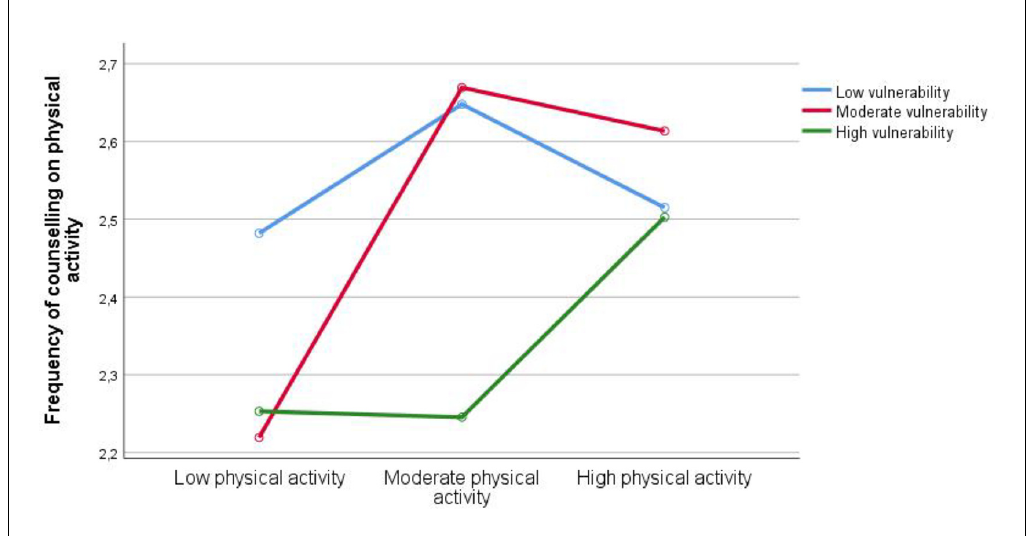
Figure 3. Interaction of vulnerability on own physical activity when counselling on physical activity